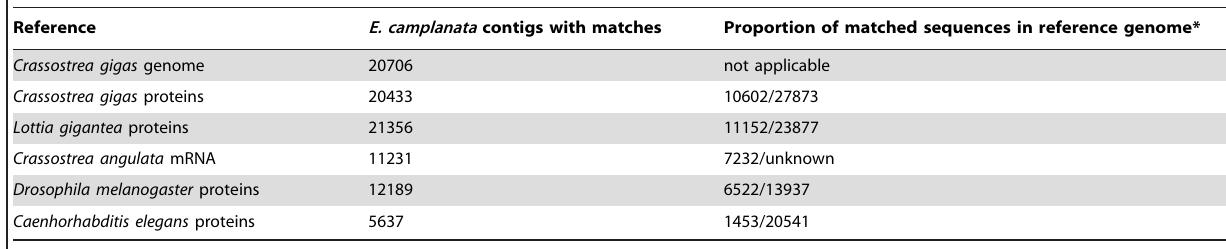
Table 2. Number of unique BLAST matches between Elliptio complanata transcriptome contigs and each reference database.